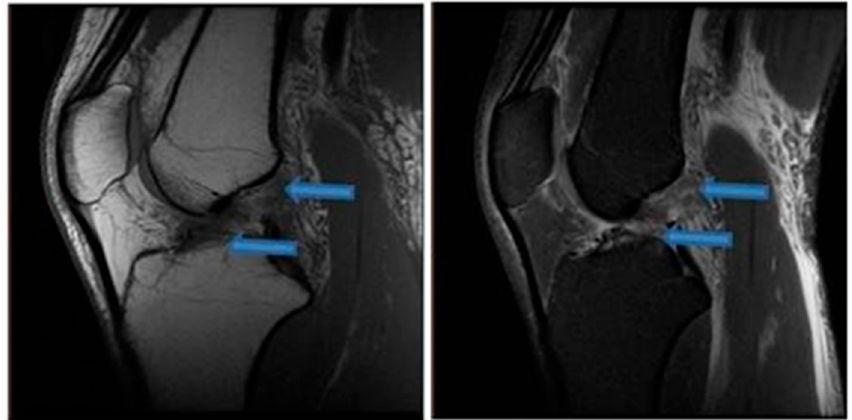
Figure 5. Sagittal T1- and T2-weighted magnetic resonance imaging of the knee demonstrating ACL detachment at the femoral origin indicated by blue arrows (20 July 2020).